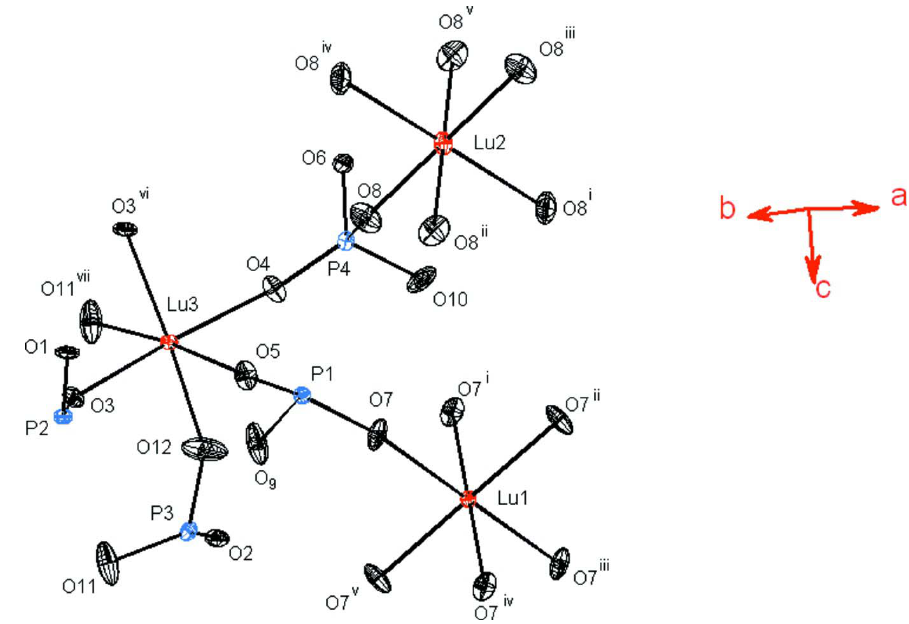
Figure 3 ) polyphosphate, showing the lutetium coordination with displacement ellipsoids drawn at the Projection of the Lu(PO 3 3 50% probability level. [Symmetry codes : (i) -y, x-y, z; (ii) -x+y, -x, z; (iii)-x+1/3, -y+2/3, -z+2/3; (iv) y+1/3, -x+y+2/3, - z+2/3; (v) x-y+1/3, x+2/3, -z+2/3; (vi) -x, -y, -z; (vii) -x+y+1/3, -x+2/3,